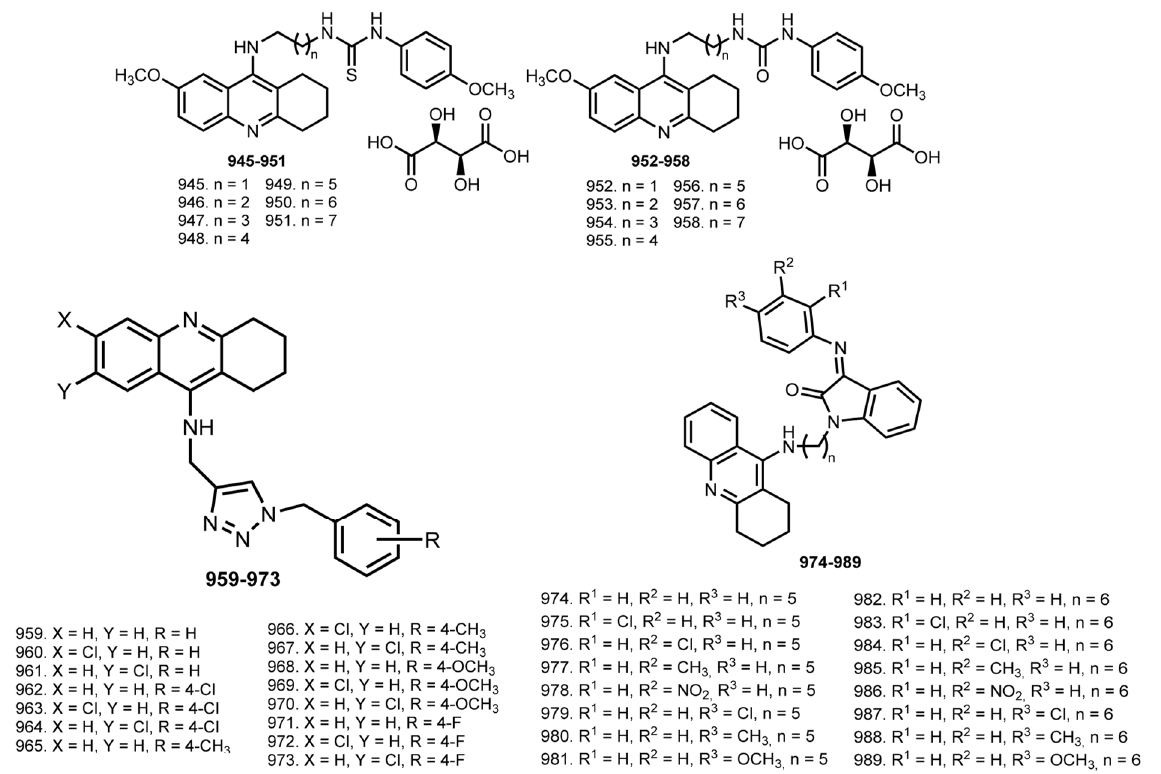
Figure 36. 7-MEOTA-p-anisidine hybrids 945 – 958 [128], THA-1,2,3-triazole hybrids 959 – 973 [129], Figure 36. 7 ‐ MEOTA ‐ p ‐ anisidine hybrids 945 – 958 [128], THA ‐ 1,2,3 ‐ triazole hybrids 959 – 973 [129], Schiff base hybrids 974 – 989 Schiff base hybrids 974 – 989 [130].